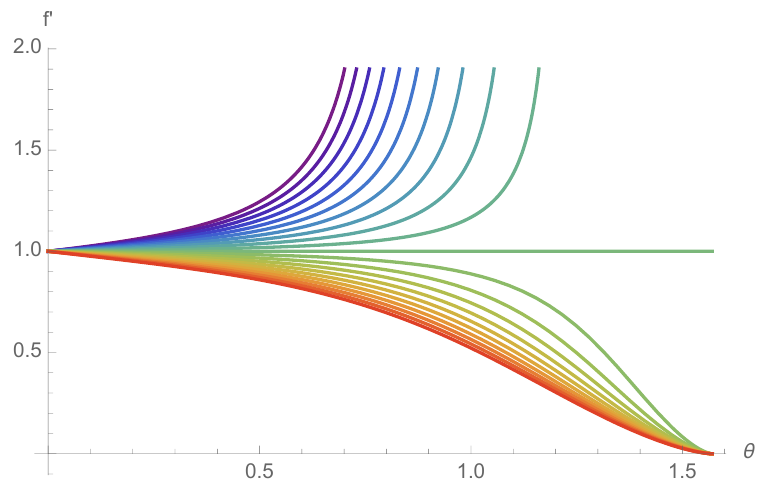
Figure 15: Equation (C.4 ) for C varying in equal steps between − 1 (blue) and 1 (red). As before, the AdS boundary is at θ = π/ 4